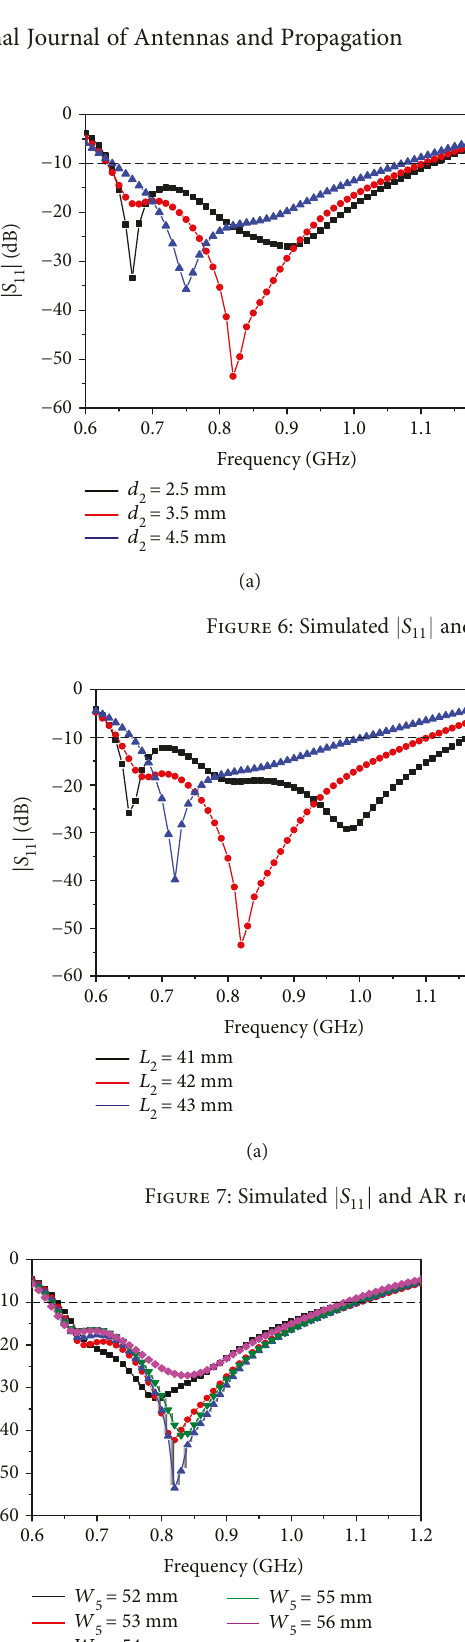
Figure 8: Simulated S ( W 5